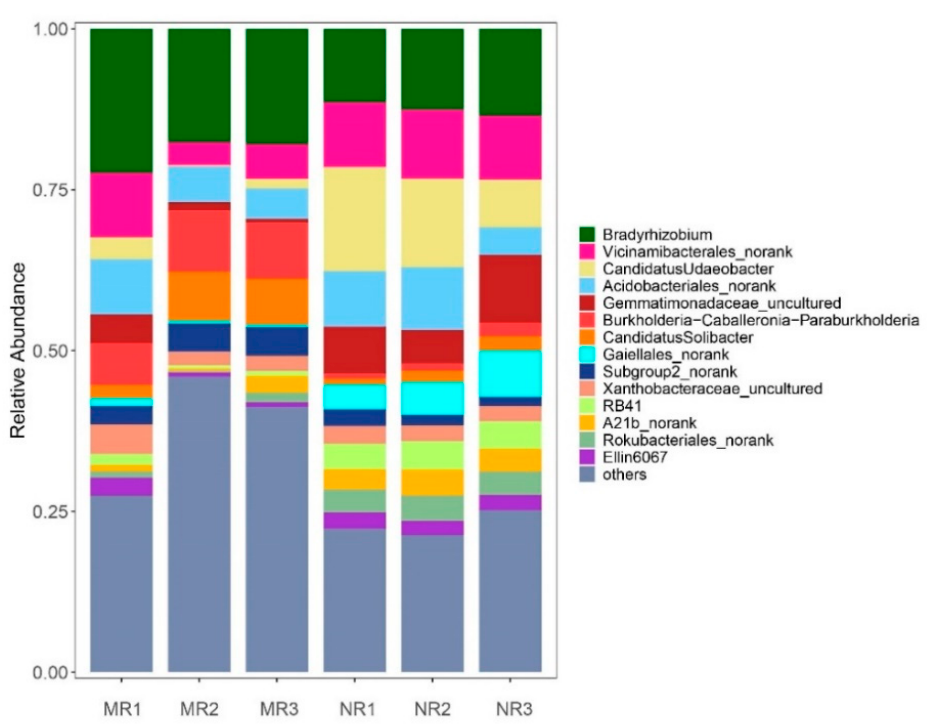
Figure 4. Relative abundance of dominant bacteria genera in rhizosphere soil. The community component of the dominant bacteria in the soil of genera that represented >1% in at least one sample, annotated by the Silva Release 138.1 database.